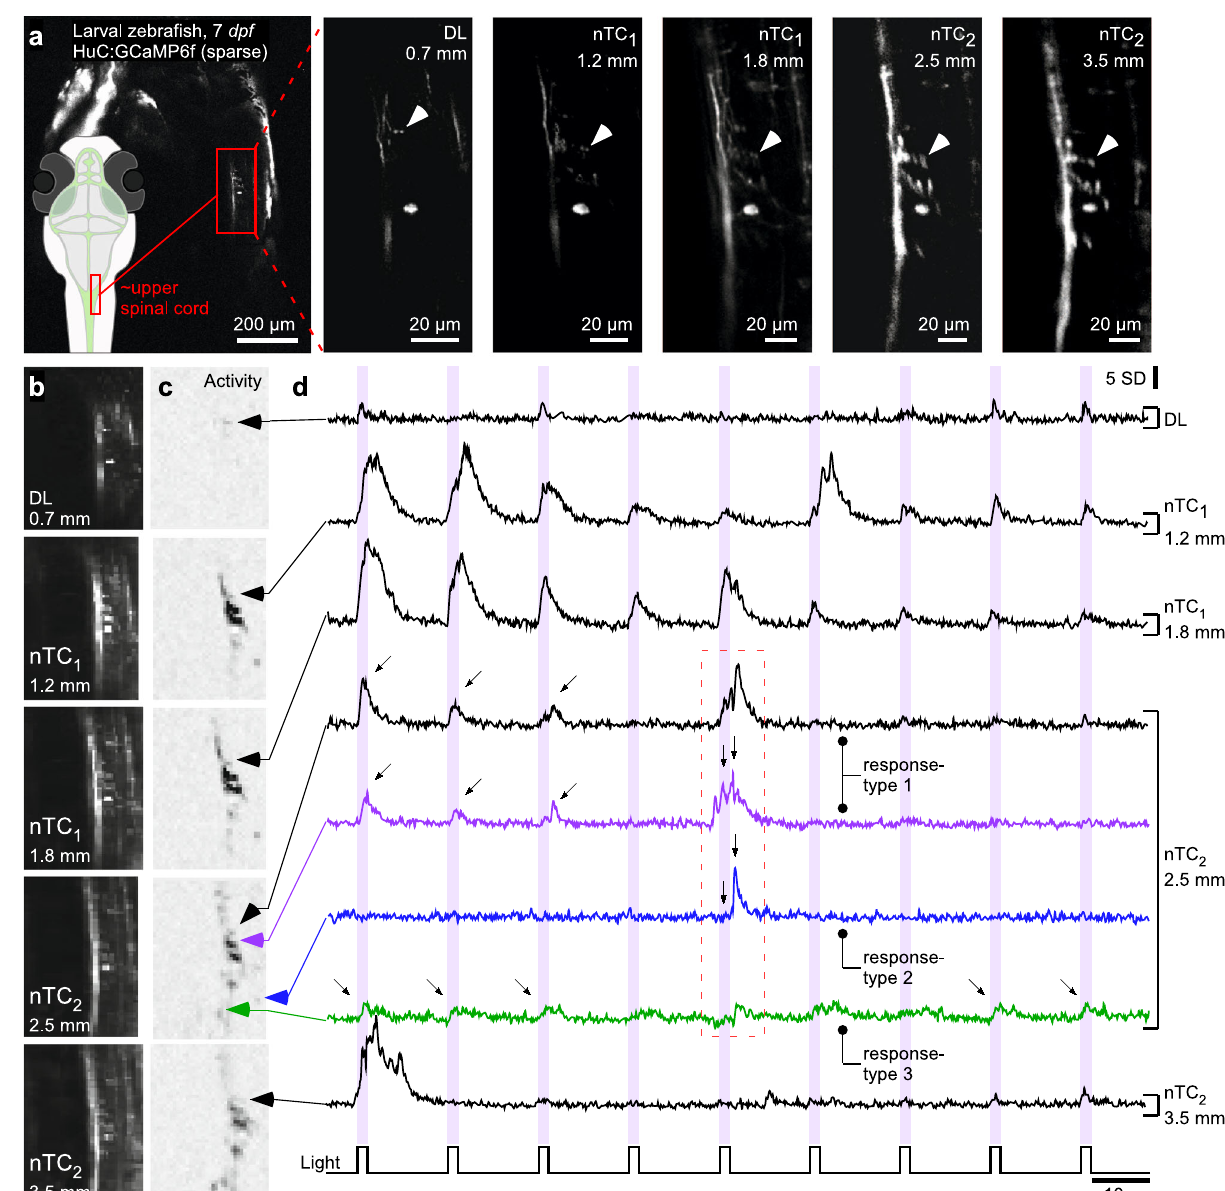
Fig. 3 In vivo calcium imaging across different optical con fi gurations. a The same set of neurons of the 7 dpf larval zebra fi sh upper spinal cord (HuC:GCaMP6f, random sparse expression, see overview scan and schematic on the left) was imaged in all optical con fi gurations as indicated at 512 × 512 px (1 Hz). Arrowheads highlight the same synaptic structures in each scan. b – d 64 × 64 px (7.81 Hz) activity scan from fi elds of view shown in ( a ) for all fi ve con fi gurations during presentation of full- fi eld fl ashes of UV-light which stochastic elicited activity in these imaged neural structures. In each case the average scan projection ( b ) and neighbour-correlation based activity projection ( c ) are shown (hereafter referred to as “ activity-correlation ” ). Darker shadings, equalised for visibility, denotes increased local activity (for details, see ref. 70 ). Black traces in ( d ) show time-traces for the same structure in all cases. For the nTC 2 2.5 mm FOV condition, time-traces from different neural structures are extracted to illustrate different responses in different structures. All activity traces in this and the following fi gures are shown in z-scores relative to their own baseline (hence y-scale in s.d.). We choose this metric over dF/F as it emphasises detectability of events rather than the relative change from the indicator ’ s baseline fl uorescence, which differs between